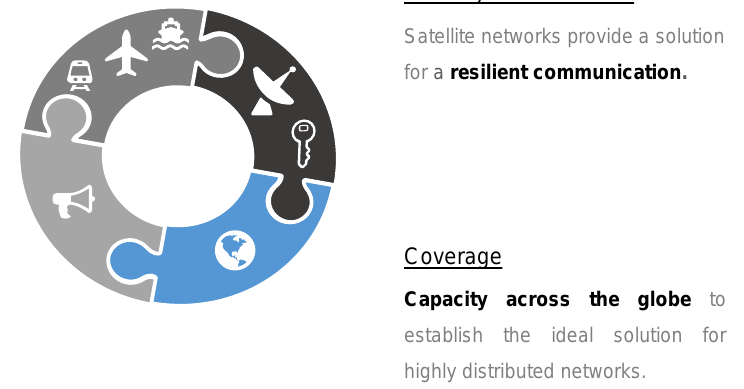
Figure 2. Key satellite features for 5G